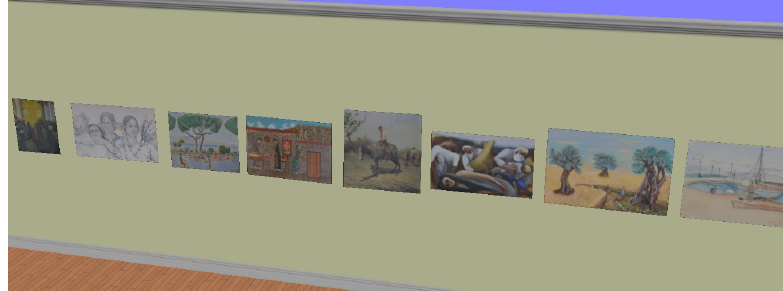
Figure 2. The setup of the virtual gallery.